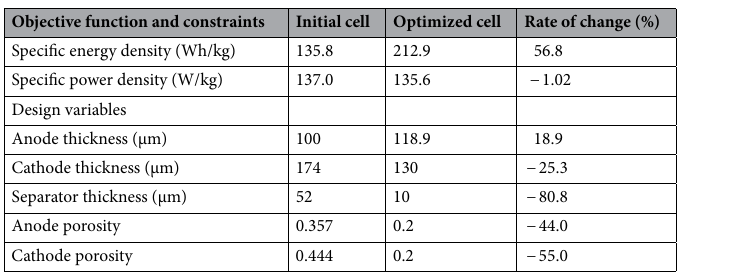
Table 6. Comparison of objective function, constraints and design variables between initial cell and optimized cell.